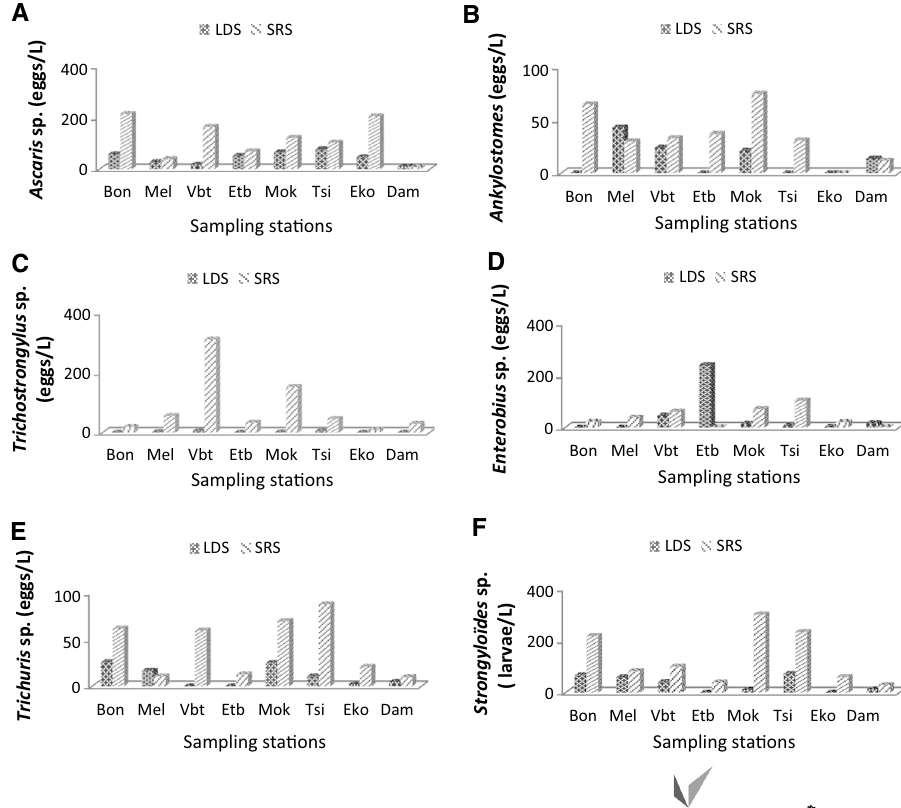
Fig. 5 Seasonal variation of the density of nematode